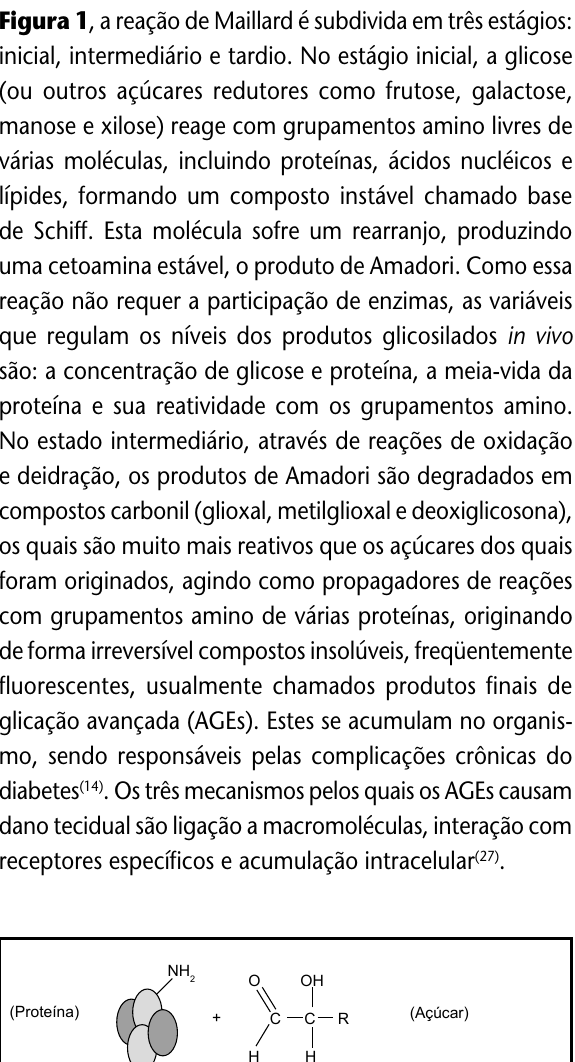
Figura 1 , a reação de Maillard é subdivida em três estágios: inicial, intermediário e tardio. No estágio inicial, a glicose (ou outros açúcares redutores como frutose, galactose, manose e xilose) reage com grupamentos amino livres de várias moléculas, incluindo proteínas, ácidos nucléicos e lípides, formando um composto instável chamado base de Schiff. Esta molécula sofre um rearranjo, produzindo uma cetoamina estável, o produto de Amadori. Como essa reação não requer a participação de enzimas, as variáveis que regulam os níveis dos produtos glicosilados in vivo são: a concentração de glicose e proteína, a meia-vida da proteína e sua reatividade com os grupamentos